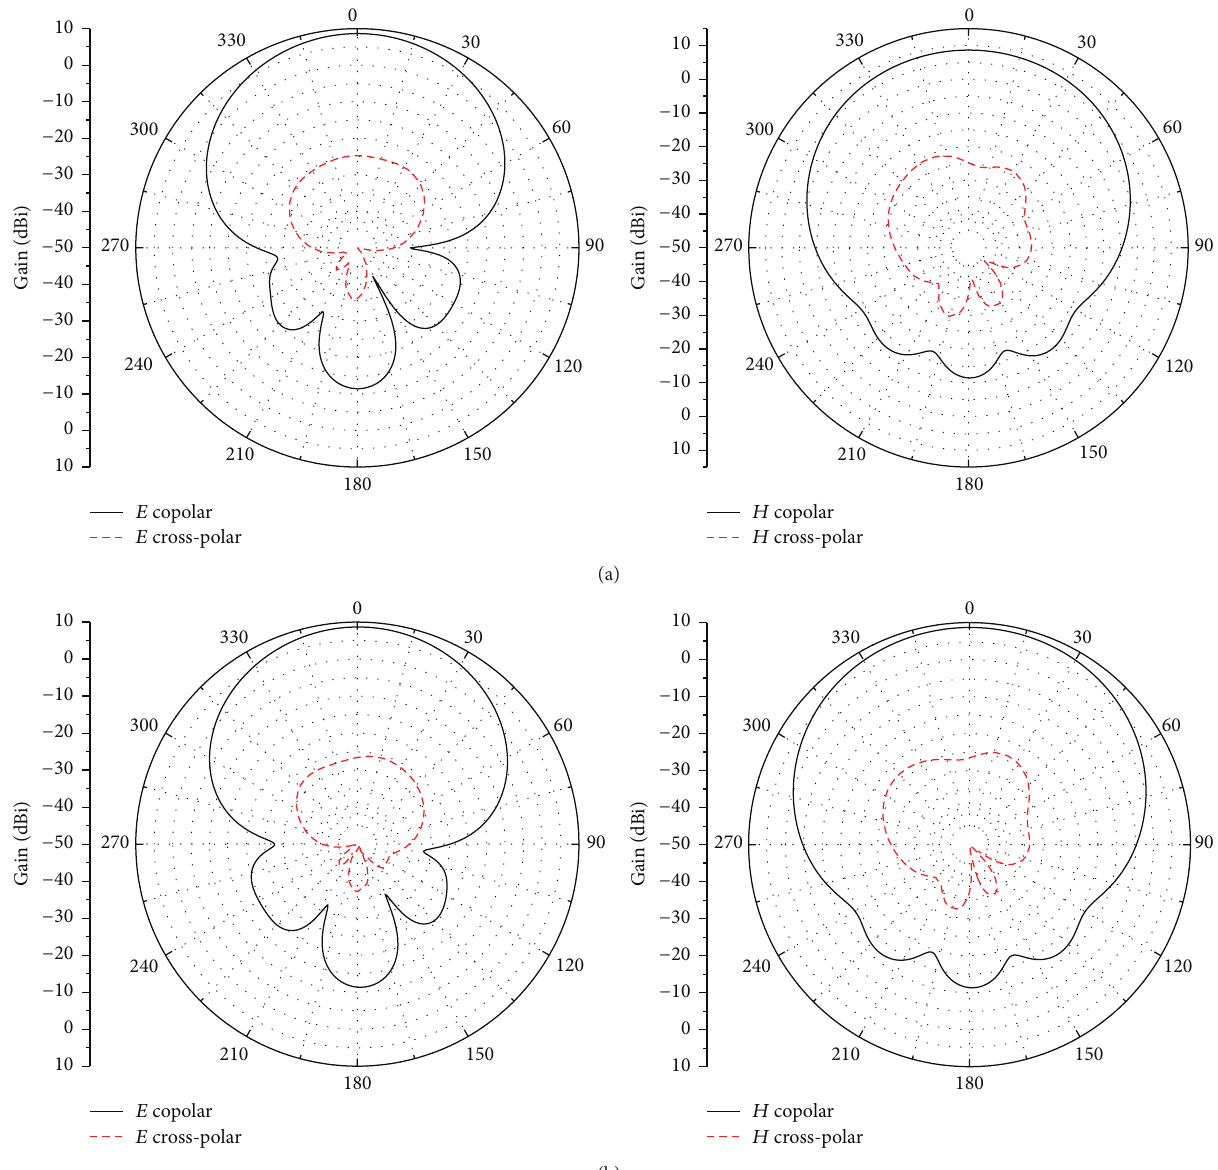
Figure 13: Radiation patterns of primary polarization and cross-polarization for the proposed antenna. (a) Only port 1 is excited. (b) Only port 2 is